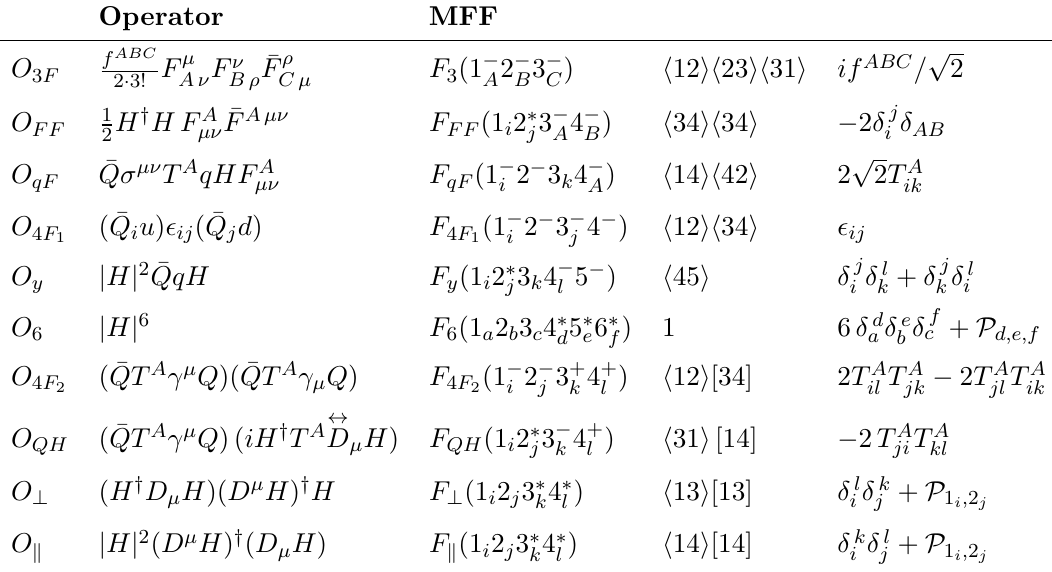
Table 1 . The Standard Model dimension-six operators and its minimal form factors (MFF) | with the least number of particles. The MFFs are given by the product of the two rightmost columns. In the right most column we give the SU(2) L and SU(3) c tensors that compound the MFF | omitting the identity in colour space and (cid:13)avour mixing matrices. (cid:22) F (cid:11)(cid:12) = F (cid:11)(cid:12) (cid:0) i(cid:15) (cid:11)(cid:12)(cid:22)(cid:23) F (cid:22)(cid:23) = 2, and T A is either of the generators of the SM gauge groups. We are not displaying operators whose